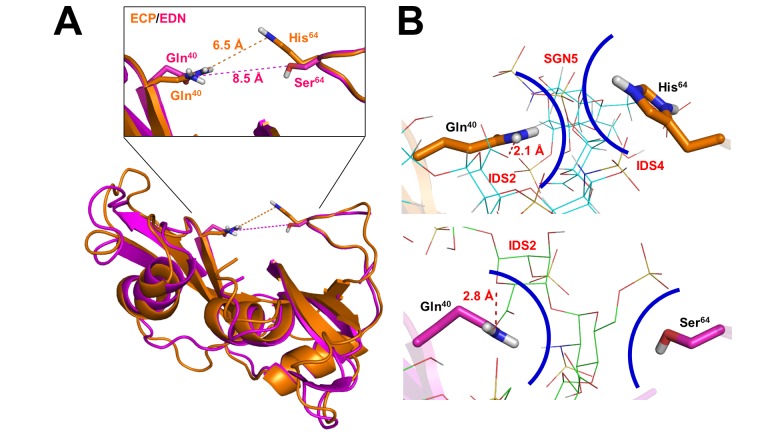
Putative heparin binding clamp in ECP with corresponding residues in EDN.(A) Superimpose analysis was performed using Lsqkab. Hep6 bound pose of ECP was superimposed on that of EDN by fitting Cα atoms of residues 40 (Gln) and 64 (His/Ser). Distances between these two residues were analyzed by PyMOL. (B) Hep6 were shown in line and CPK color. Residues were shown in orange (ECP) and pink (EDN) sticks. Hydrogen bonds were shown in red dashed lines with indicated distance. The vDW forces between the corresponding residues on ECP/EDN and the surrounding sugar moieties with indicated moiety name and number were shown as curve colored in blue indicate. SGN, 6-O-sulfated, N-sulfated glucosamine; IDS, 2-O-sulfated iduronic acid.